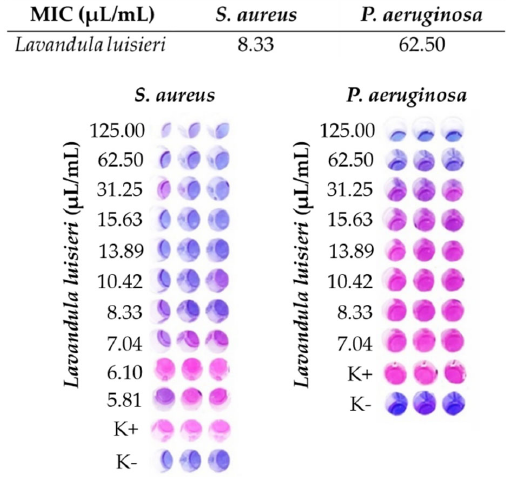
Figure 2. Well plate test and MIC of Lavandula luisieri oil.